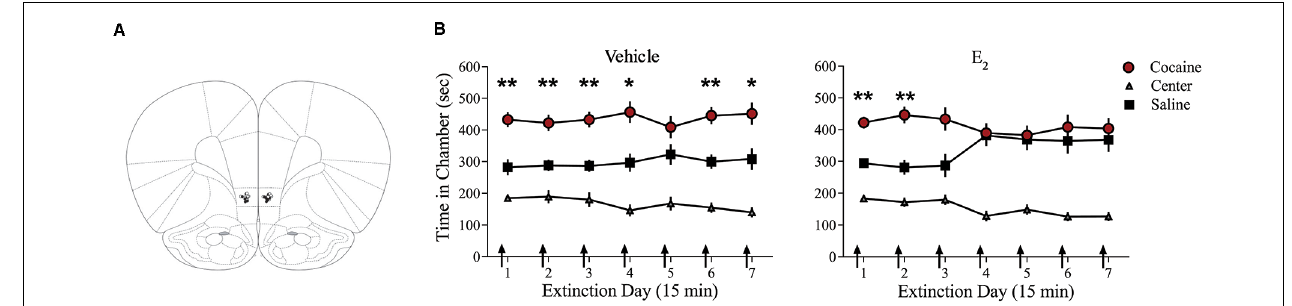
FIGURE 1 | Infusions of E 2 into infralimbic-medial prefrontal cortex (IL-mPFC) enhance extinction of a cocaine conditioned place preference (CPP). (A) Coronal drawings showing injector tip placements for IL-mPFC infusions. (B) IL-mPFC infusions (arrows) of E 2 ( n = 21) but not vehicle ( n = 21) before each CPP trial promoted extinction of a CPP. ∗∗ p < 0.01, and ∗ p < 0.05. Error bars indicate SEM.